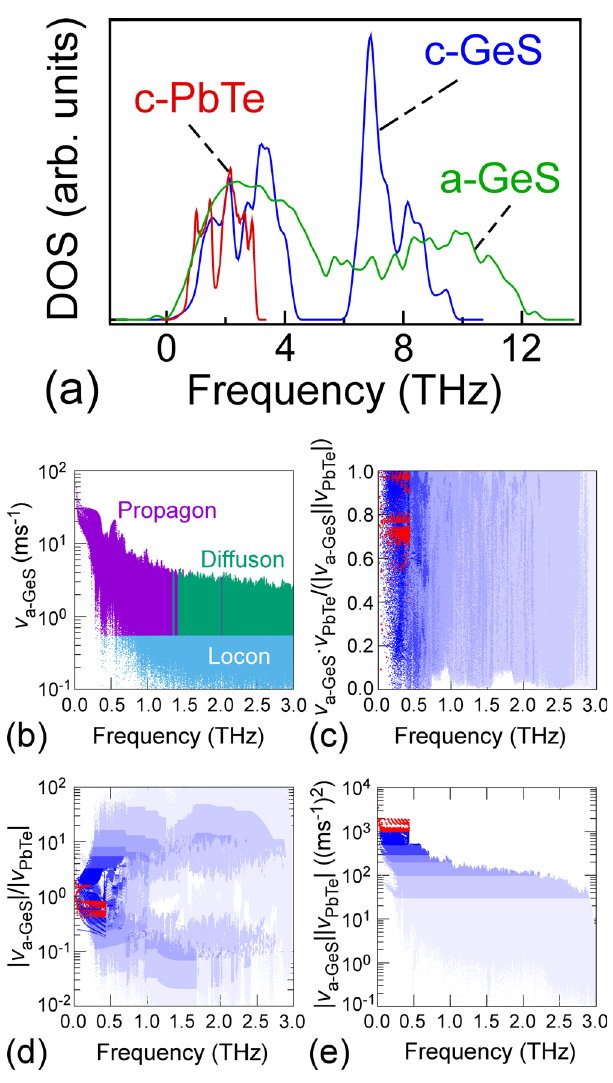
Fig. 4 Lattice dynamics calculation results. a Phonon (or vibron) density- of-states (DOS) of c-PbTe, c-GeS, and a-GeS obtained by lattice dynamics calculation. b Vibron frequency dependence of phonon group velocity ( v g ) in a-GeS, where the vibron is classi fi ed into propagon, diffuson, and locon. c, d Vibron frequency dependence of c correlation coef fi cient ( v a-GeS · v PbTe / (| v a-GeS || v PbTe |)) and d amplitude ratio (| v a-GeS |/| v PbTe |) between v a-GeS and v PbTe . The colors in c and d display the amplitude product (| of the two v g s. e Value of the amplitude product (| v a-GeS | | v PbTe |) as a function of vibron frequency. v a-GeS and v PbTe are de fi ned as the v g vectors in a-GeS and c-PbTe,